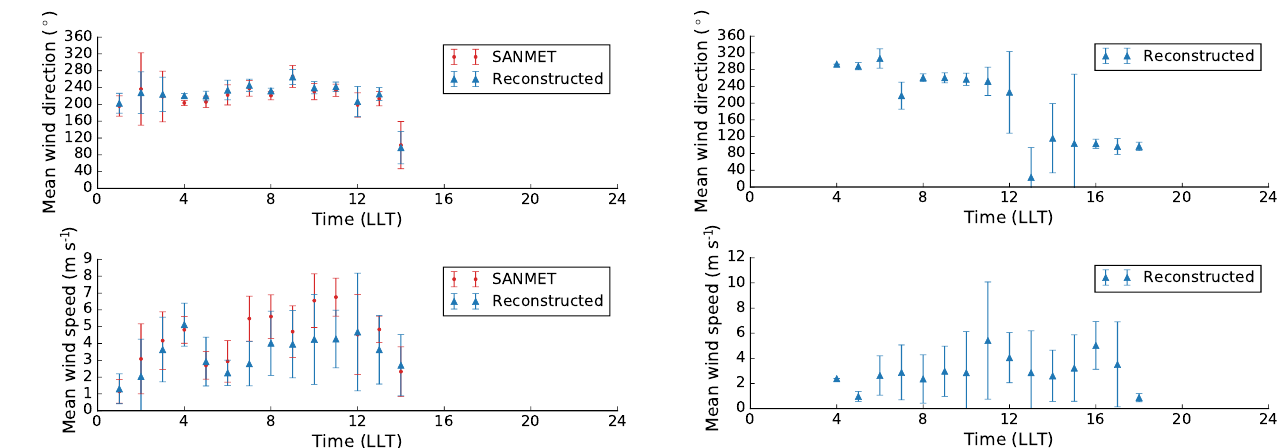
Figure 26. Comparison of SANMET and reconstructed hourly wind directions and speeds for sol 15.